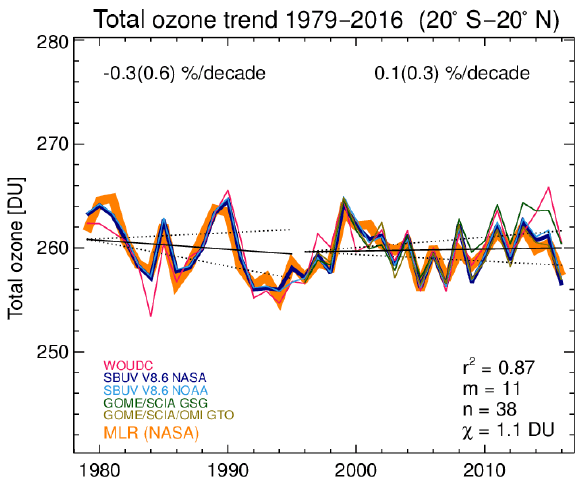
Figure 6. Same as Fig. 2 but for the 20 ◦ S–20 ◦ N zonal band (trop- ics) and MLR applied to NASA SBUV MOD v8.6. In the tropics, the standard MLR plus BDC-S term was